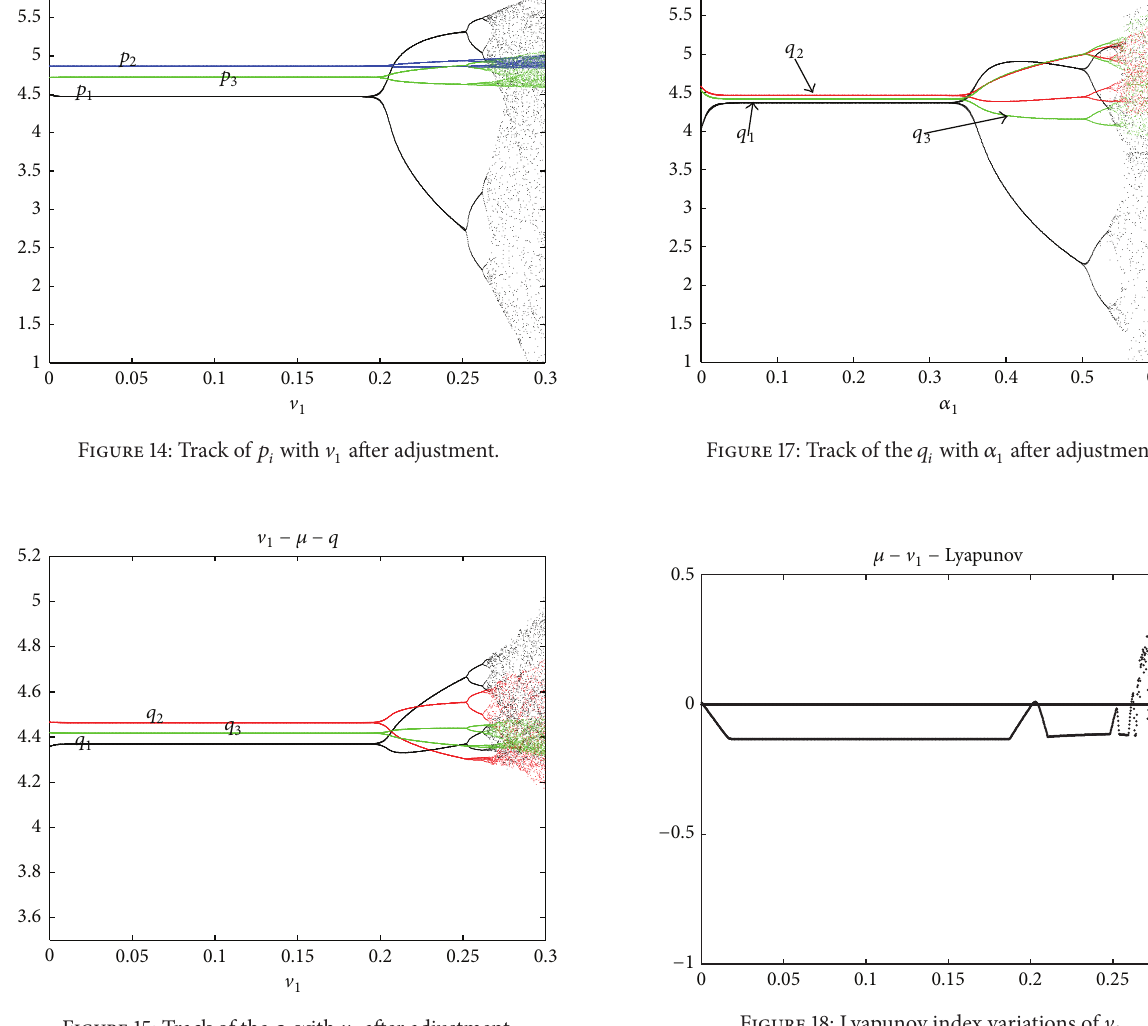
Figure 15: Track of the 𝑞 𝑖 with V 1 after adjustment.